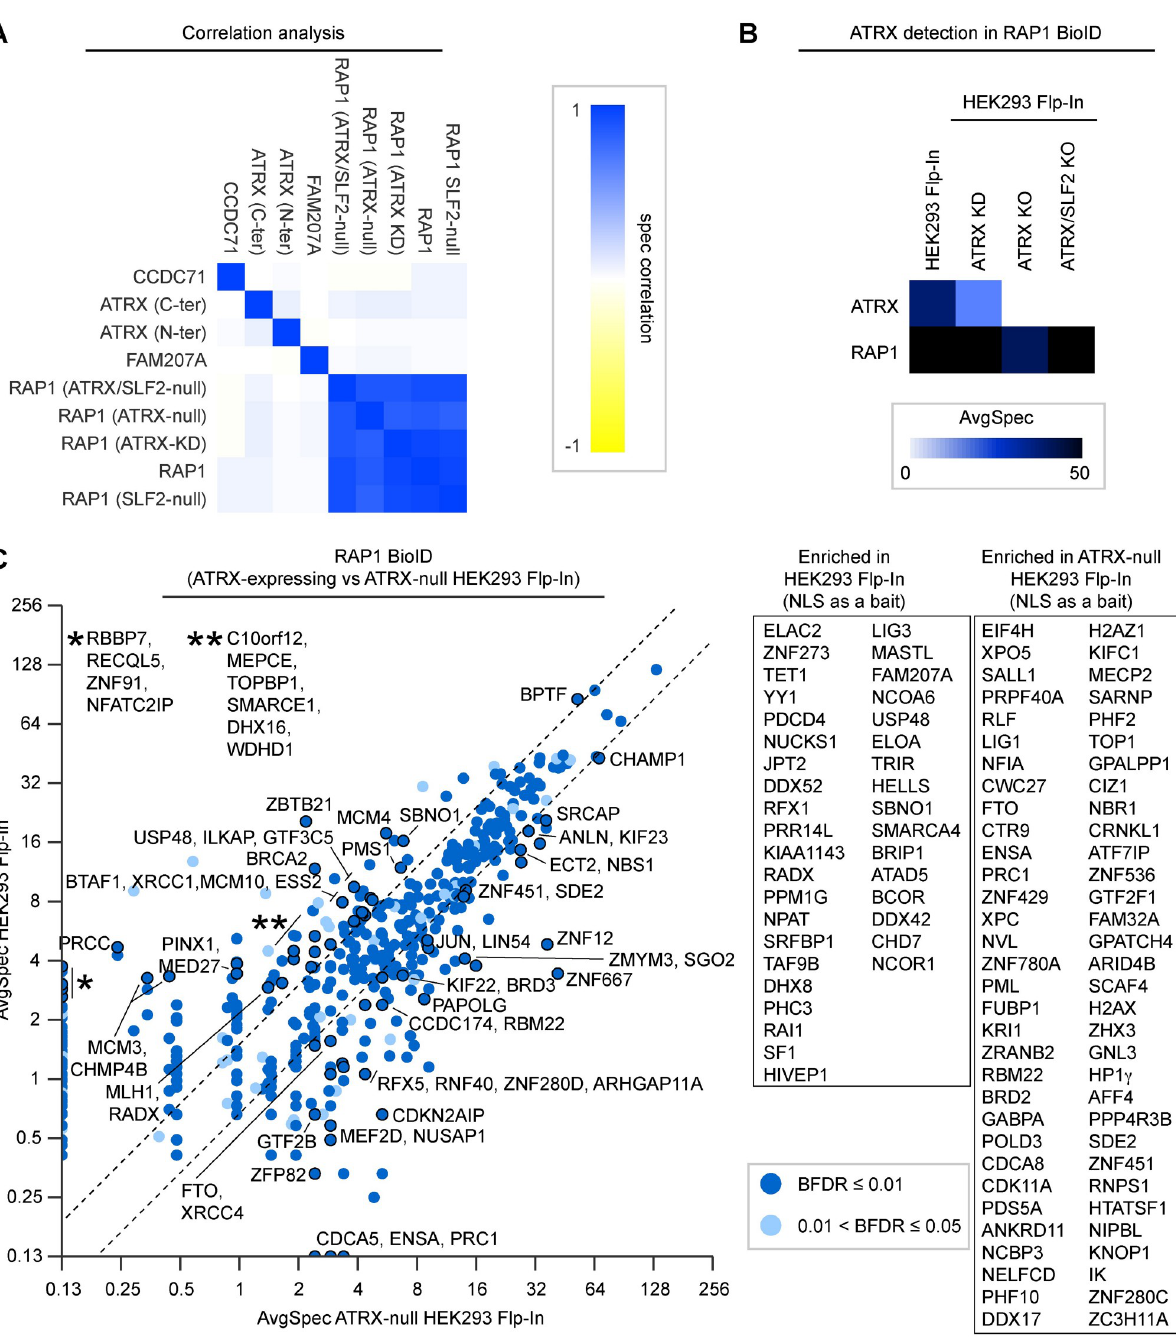
PLOS Genetics | https://doi.org/10.1371/journal.pgen.1009909 November 15,